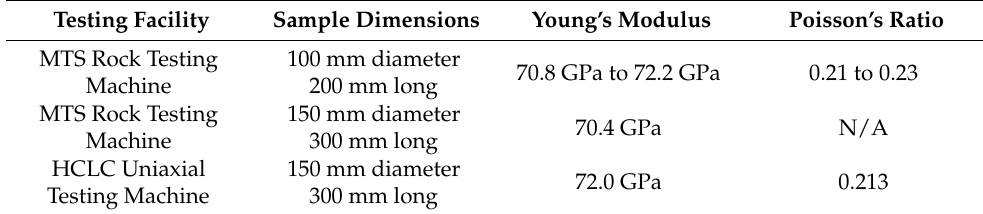
Figure 2. Experimental arrangement for performing uniaxial compression tests on the Lac du Bonnet granite cylinders. Table 1. Elasticity properties of the Lac du Bonnet granite—Environmental Geomechanics Laboratory, McGill